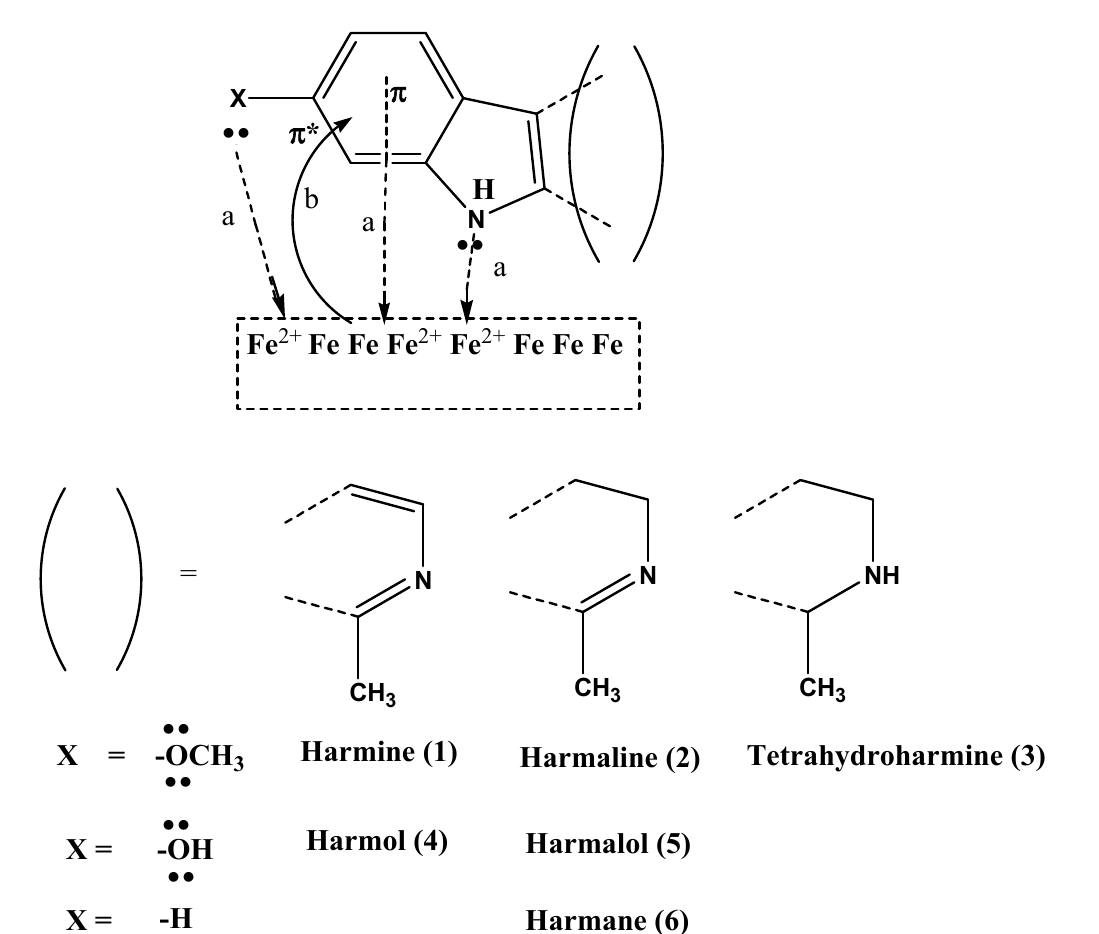
Figure 11. Inhibition mechanism based on chemical adsorption of the Harmal molecules from Harmal plant extracts HRE, HLE, and HFE. ( a ) σ bonds and ( b ) π back bonds are shown for the coordinate bonds between the Harmal molecules and Fe or Fe 2+ on the C-steel surface.